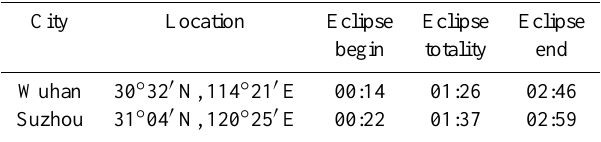
Table 1. Location and solar eclipse time of Wuhan and Suzhou.